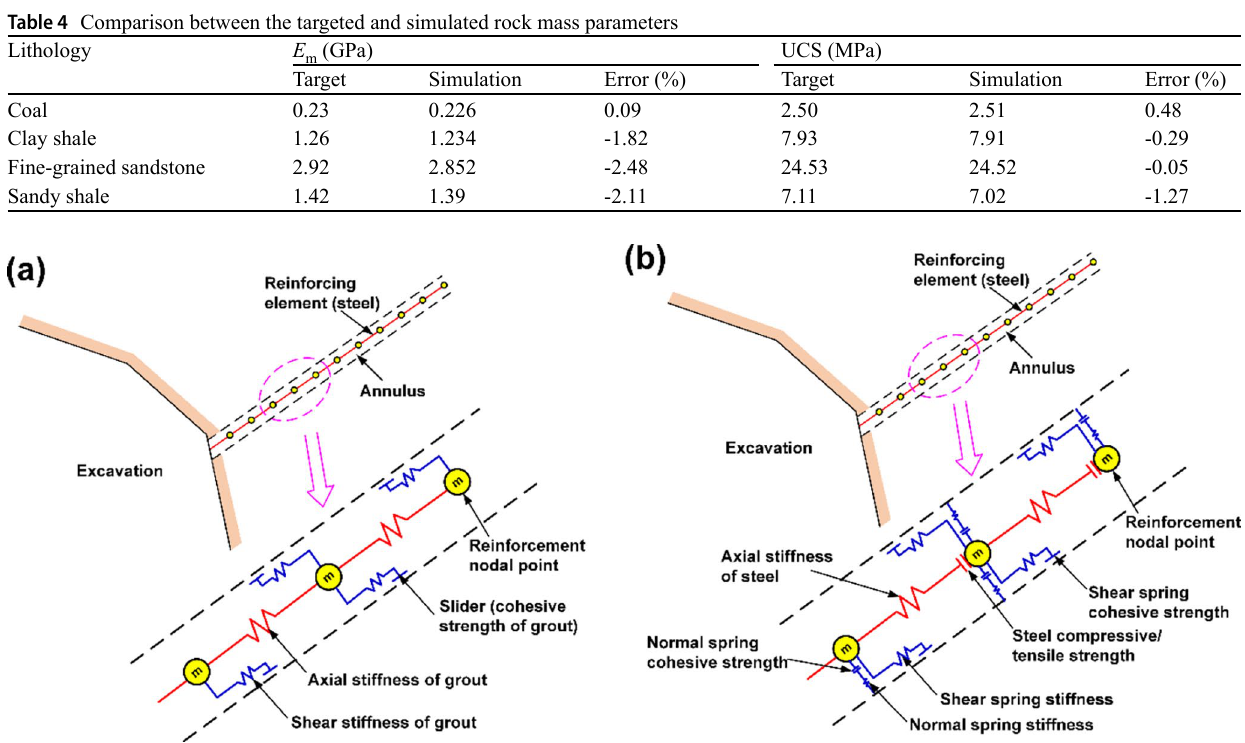
Fig. 7 Conceptual mechanical representation of the global reinforcement: a “cable” element, which accounts for shear behavior of the grout annu- lus, and b “rockbolt” element, which accounts for shear behavior of grout annulus and bending resistance of the reinforcement (after Itasca